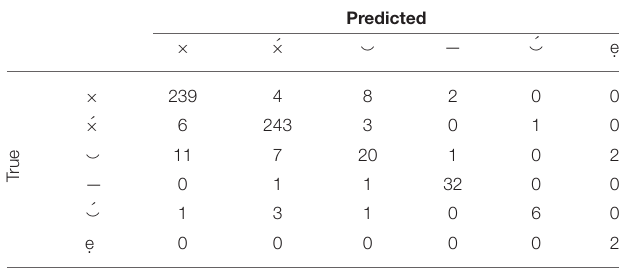
TABLE 4 | Top ten CRF features and Brill rules. CRF Brill